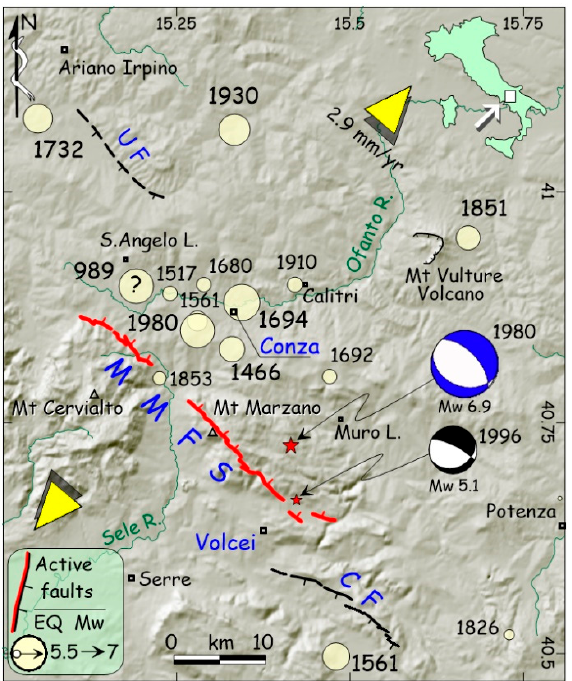
Figure 1. Macroseismic epicenters of Mw > 5.5 earthquakes in southern Irpinia (modified from [7]). Notwithstanding possible approximate location, earthquakes cluster mainly in the hanging wall of the Monte Marzano Fault System (MMFS). CF, Caggiano fault; UF, Ufita fault. Stars are the instrumental epicenters of 1980 (Mw 6.9; epicenter from [8]) and 1996 (Mw 5.1) events. Diverging triangles indicate crustal extension, as deduced by GPS analyses published by [4,5].